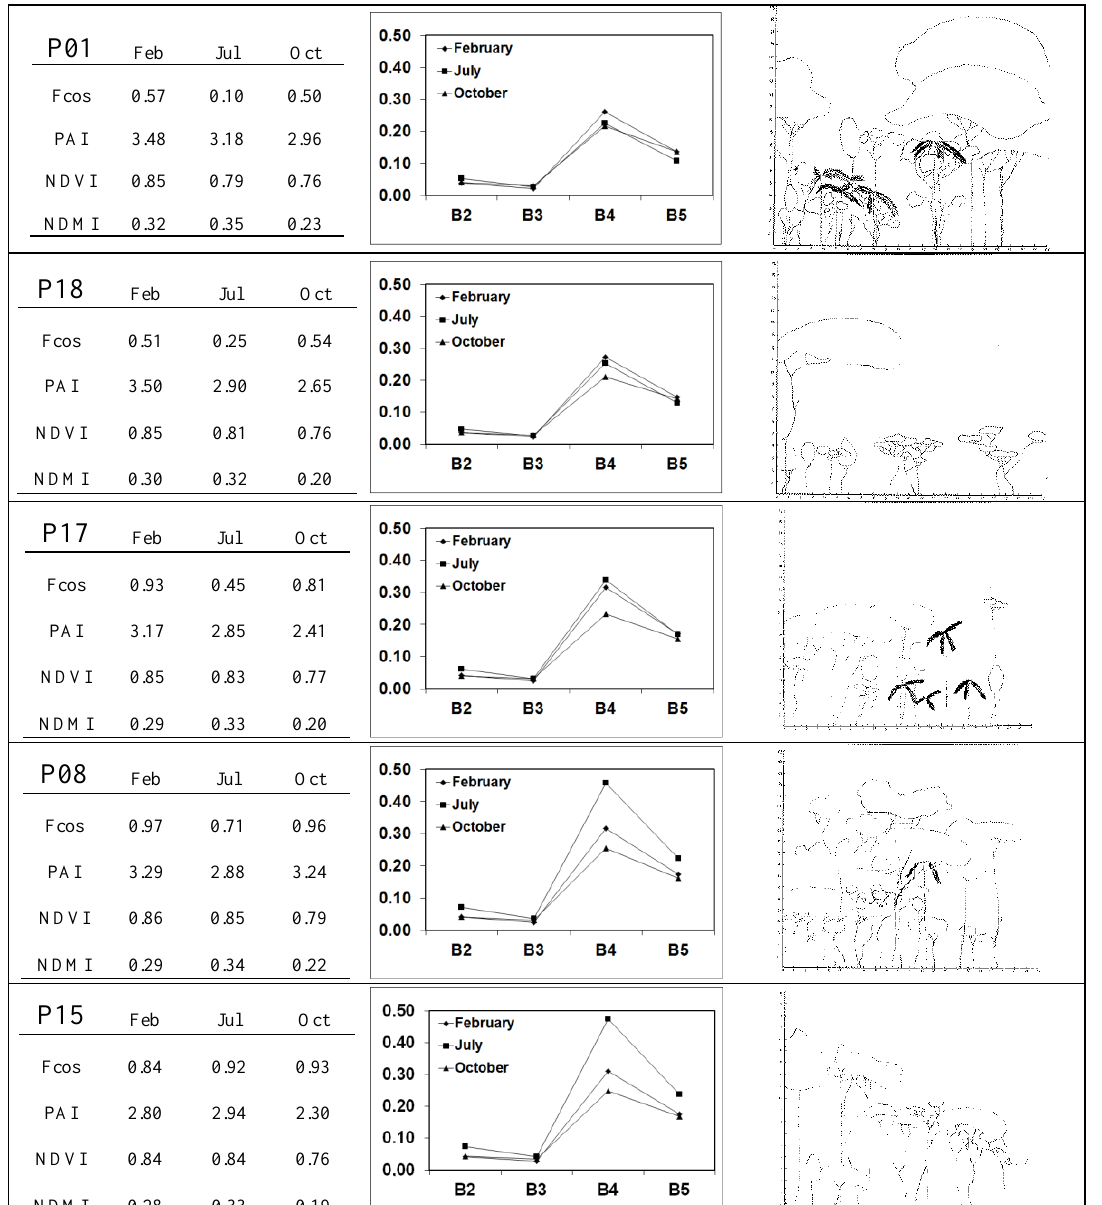
Figure 3. Examples of LISS-3 spectra and the canopy vertical profiles of some sample points under different local illumination